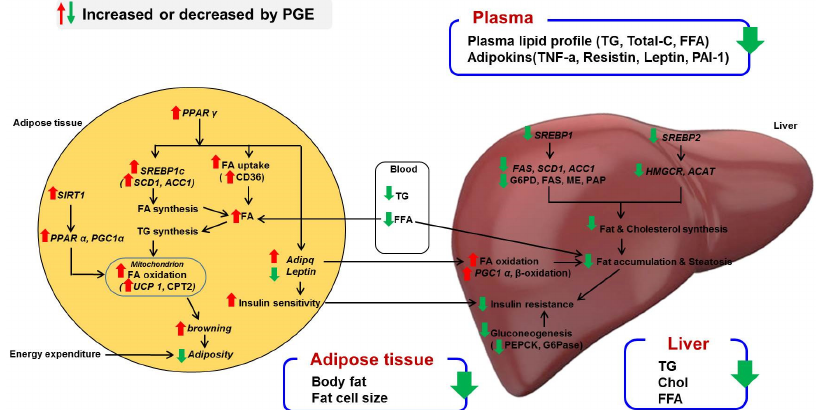
Figure 4. Proposed mechanism for PGE regarding anti ‐ obesity effects. Schematic representation of the role of PGE in amelioration of obesity. PGE can contribute to browning of WAT in diet ‐ induced obese mice through increasing fatty acid oxidation in mitochondria, which promotes energy expenditure. In addition, PPAR γ activation by PGE controls adipokines, specifically the insulin ‐ sensitizing hormones adiponectin and leptin. In the liver, PGE downregulates the mRNA expression of lipogenesis and cholesterol synthesis transcription factors, SREBP1 and SREBP2, thereby reducing hepatic steatosis and insulin resistance. PPAR γ , peroxisome proliferator ‐ activated receptor γ ; SREBP1a, ‐ 1c, and ‐ 2, sterol regulatory element ‐ binding proteins 1a, 1c, and 2; FAS, fatty acid synthase; ACC, acetyl ‐ CoA carboxylase; SCD1, stearoyl ‐ CoA desaturase; HMGCR, 3 ‐ hydroxy ‐ 3 ‐ methylglutaryl ‐ CoA reductase; ACAT, acetyl ‐ CoA acetyltransferase; SIRT1 , sirtuin 1; PPAR α , peroxisome proliferator ‐ activated receptor α ; PGC1 α , peroxisome proliferator ‐ activated receptor gamma coactivator 1 ‐ alpha; UCP1 , uncoupling protein 1; TNF ‐α , tumor necrosis factor ‐α ; CPT2, carnitine palmitoyltransferase 2.